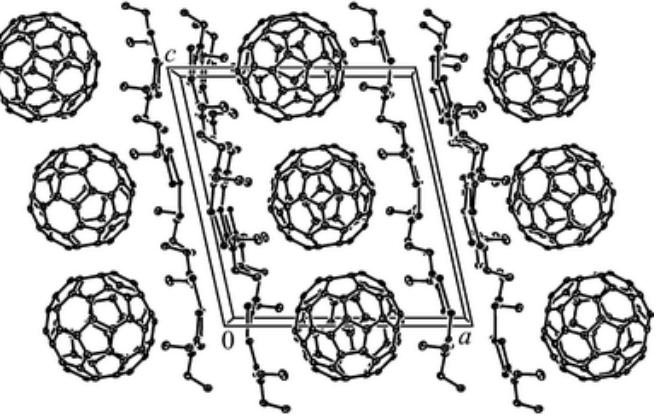
Figure 4. Molecular structure of [Cu(S 2 CNEt 2 ) 2 ]·C 60 . Reproduced with permission from [50]. Copyright 2005 The Royal Society of Chemistry.